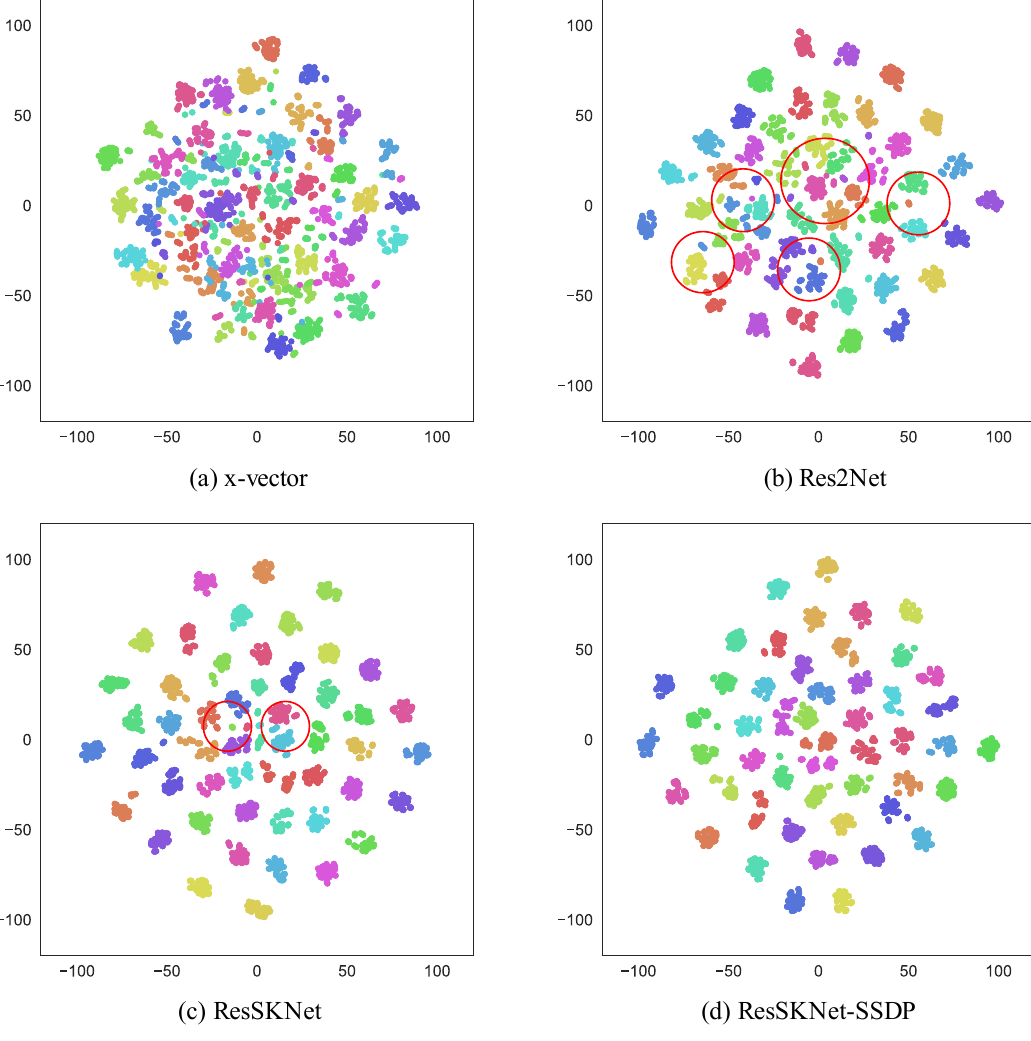
Figure 7. t-SNE visualization results.